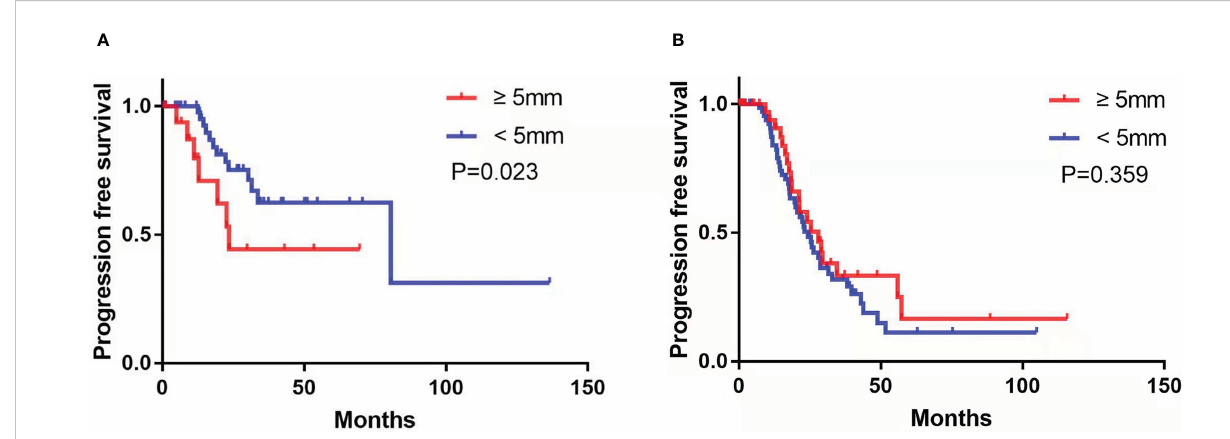
FIGURE 4 Progression-free survival in patients with no residual disease (A) and residual disease (B) after primary debulking surgery with cardiophrenic lymph nodes (CPLN) of ≥ 5 mm versus <5